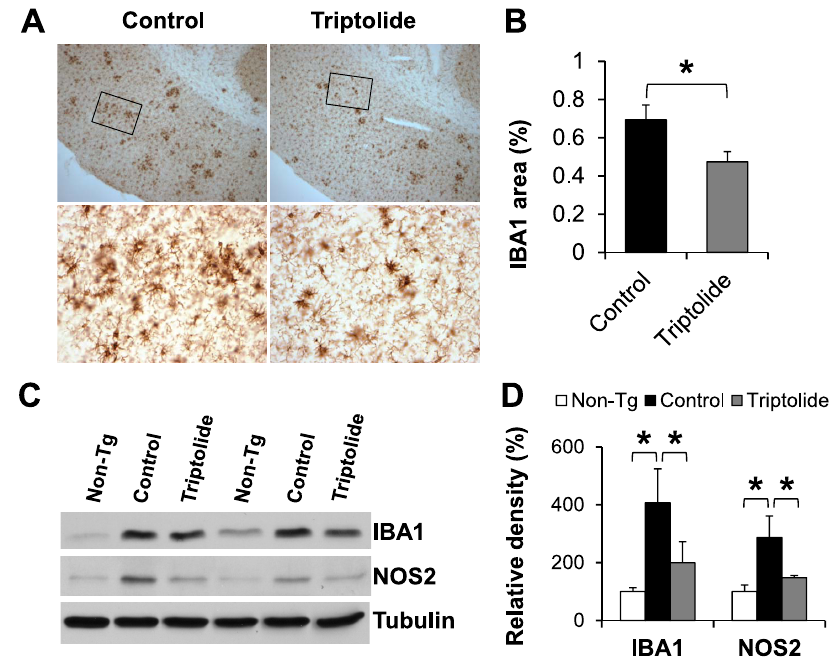
Figure 7. Triptolide treatment attenuates neuroinflammation in APP/PS1 mice. A , Representative photomicrographs of activated microglia stained with IBA1 antibody. B , Quantification of percent IBA1 immunoreactivity in the cortex of triptolide-treated and control mice. C , Immunoblot analysis of IBA1 and NOS2 levels in the cerebral homogenates. D , Densitometric analysis of IBA1 and NOS2 immunoblots (normalized by the amount of tubulin), with the levels in the non-Tg group set as 100%. The levels of IBA1 and NOS2 were elevated in control APP/PS1 mice but significantly attenuated in triptolide-treated APP/PS1 mice. N=7 mice/group; Age =8.6 months; *, P , 0.05.